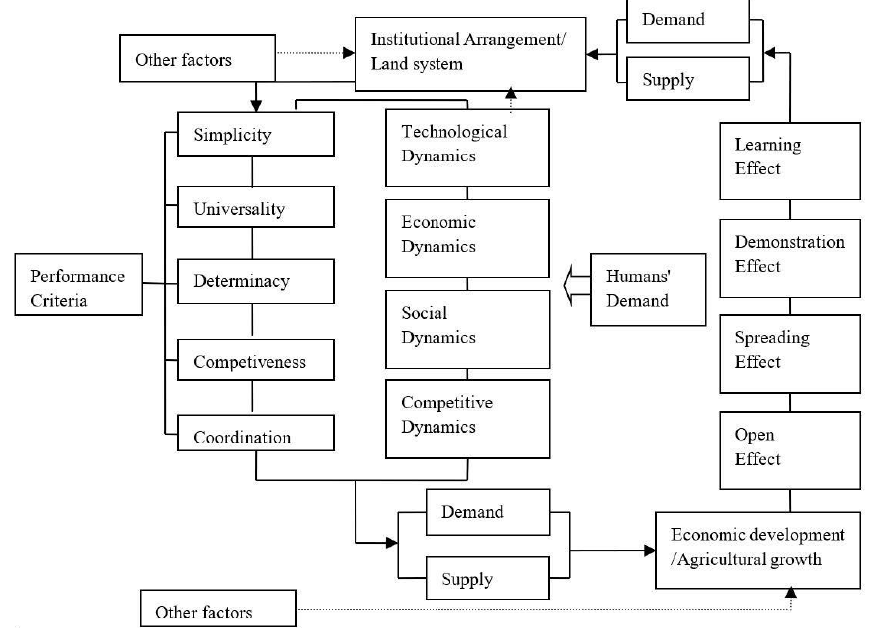
Figure 1. Institutional change and economic development.